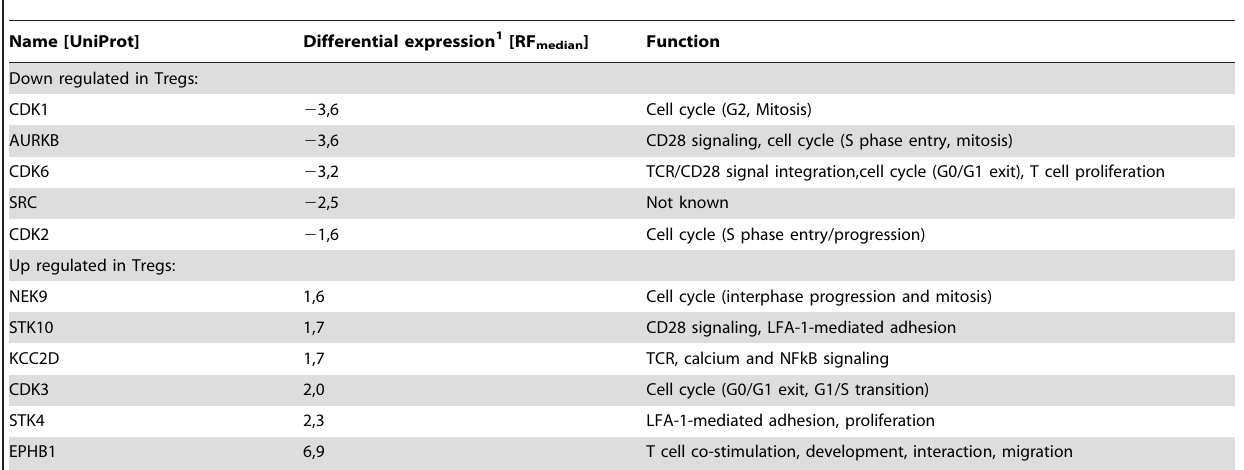
Table 2. Differential kinase abundances in Tregs and